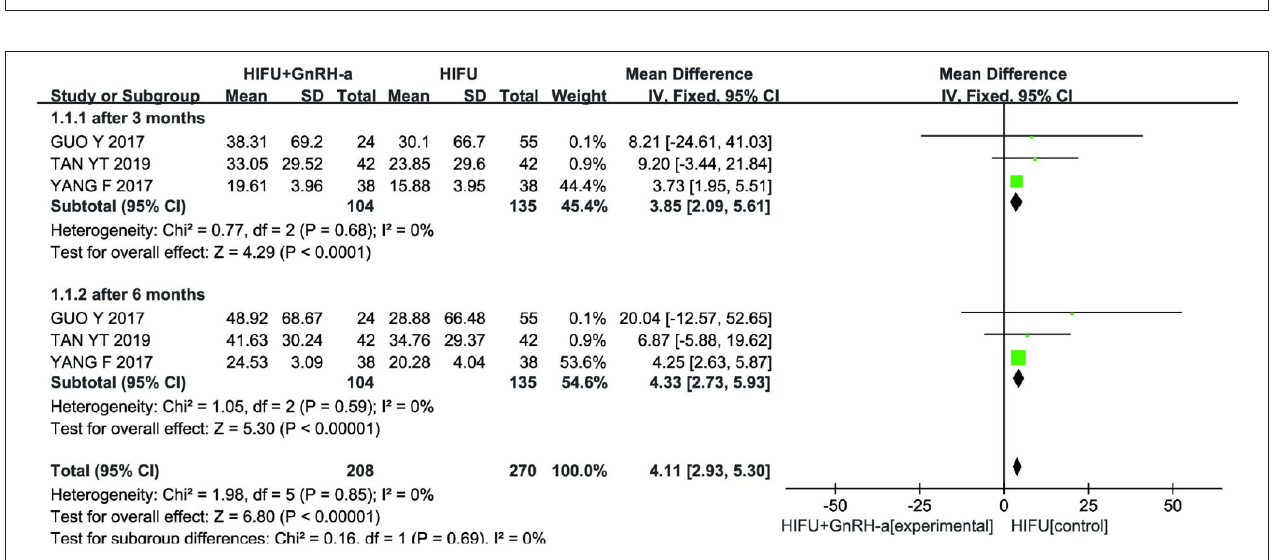
FIGURE 4 | Meta-analysis of uterine volume changes in two groups.